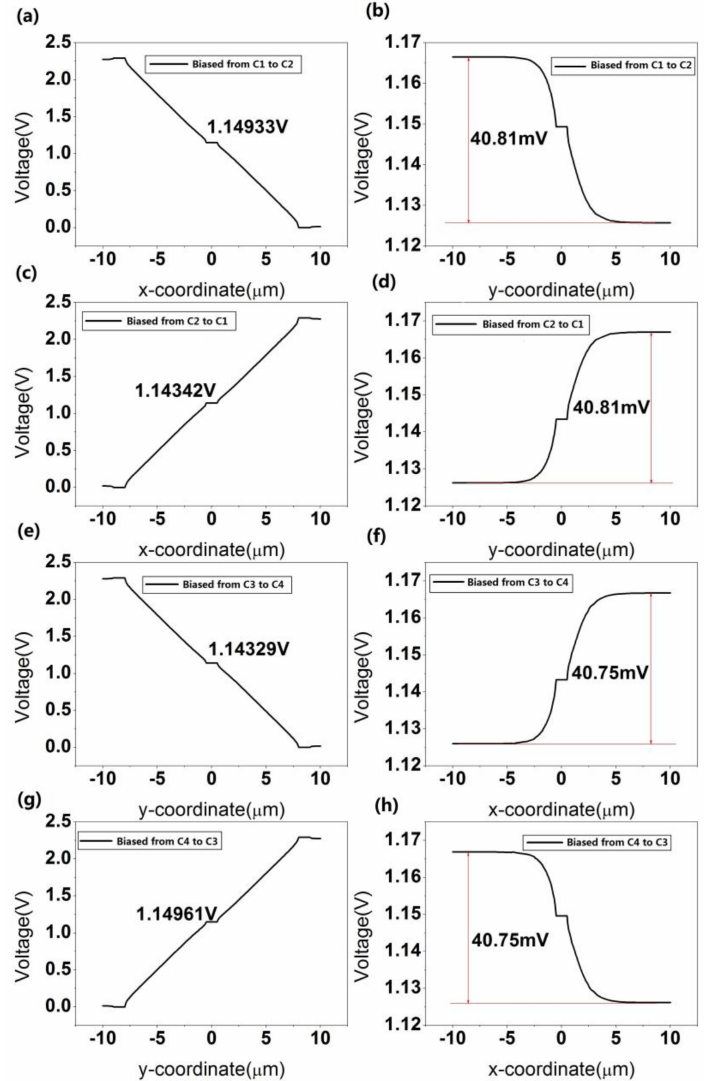
Figure 13. Simulation for cross-shaped 3D Hall device under different biases. ( a , b ) Distribution of voltage in x and y directions when biased from C1 to C2, respectively. ( c , d ) Distribution of voltage in x and y directions when biased from C2 to C1, respectively. ( e , f ) Distribution of voltage in y and x directions when biased from C3 to C4, respectively. ( g , h ) Distribution of voltage in y and x directions when biased from C4 to C3,